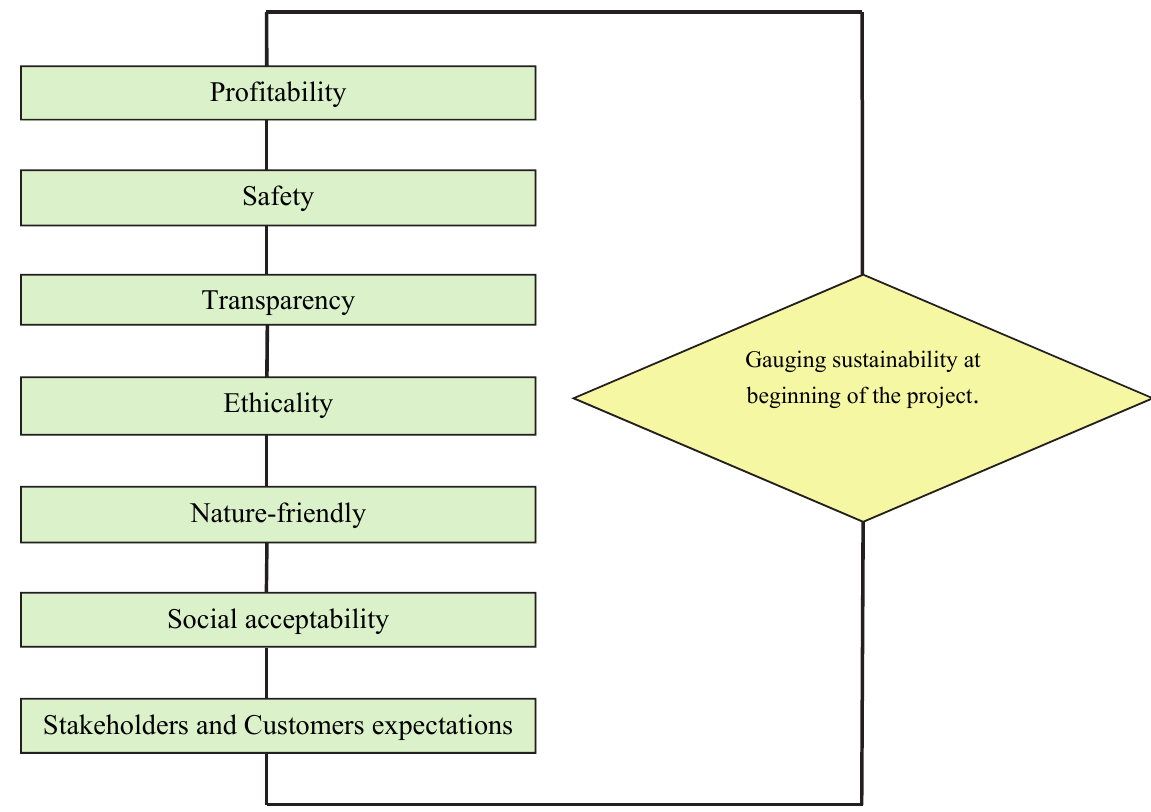
Fig. 1. Critical parameters to gauge sustainability in the